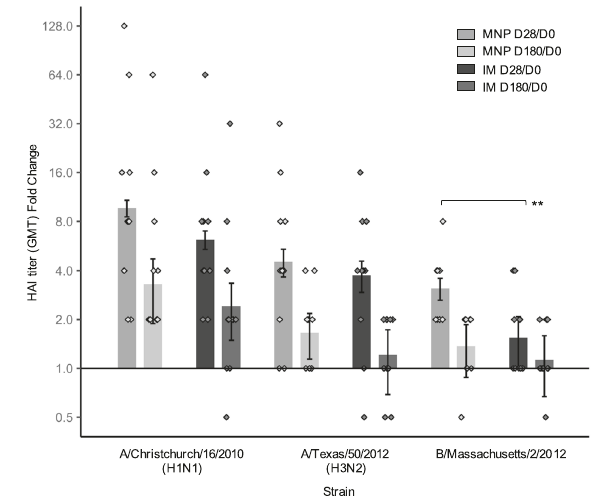
Fig. 1 Fold change of hemagglutination inhibition (HAI) geo- metric mean titers (GMT) (log2) over baseline level at Day 28 and Day 180 following vaccination against A/Christchurch/16/2010, NIB-74 (H1N1), A/Texas/50/2012, NYMC X-223 (H3N2), B/Massa- chusetts/2/2012, NYMC BX-51(B) strains for MNP ( n = 11) and IM ( n = 11) groups with geometric standard error (vertical bars). Black lines indicate statistical signi fi cance based on Wilcoxon rank- sum test. ** P < 0.01. IM, IIV by intramuscular route; MNP, IIV by microneedle patch; D, Day.